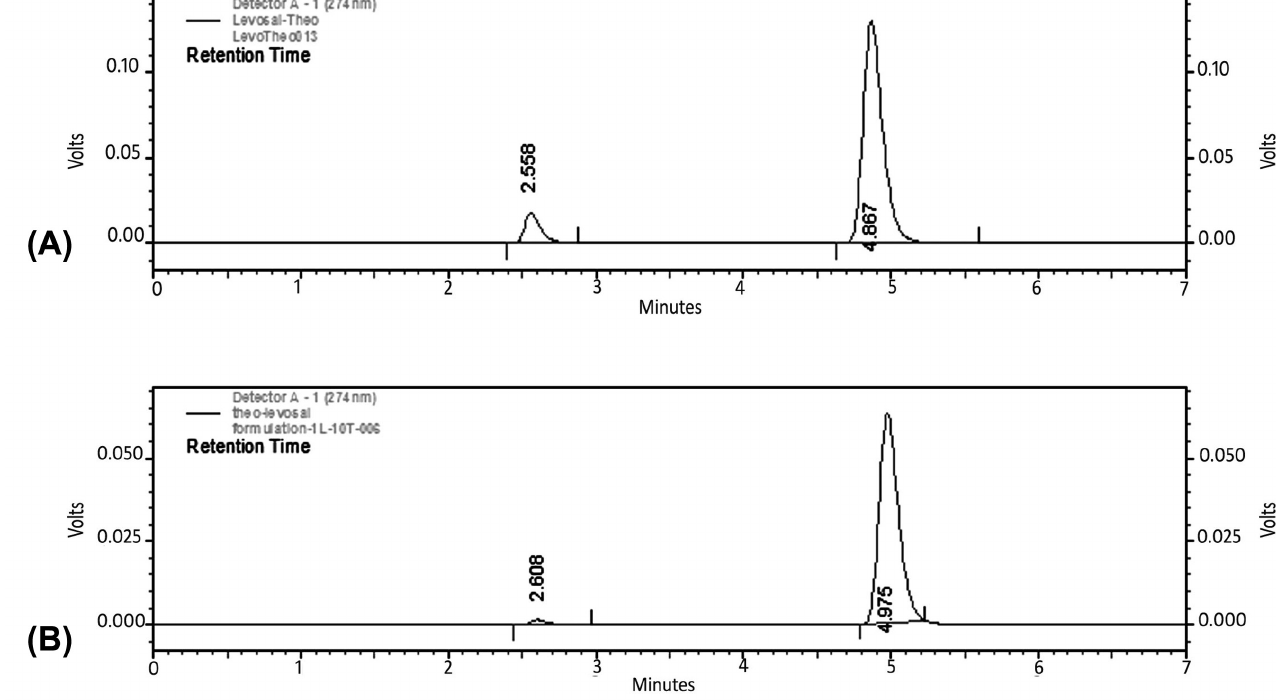
FIGURE 2 - Representative chromatograms of levosalbutamol sulfate and theophylline. (A) combined standard drugs[ratio 1:1] (B) combined formulation[ratio